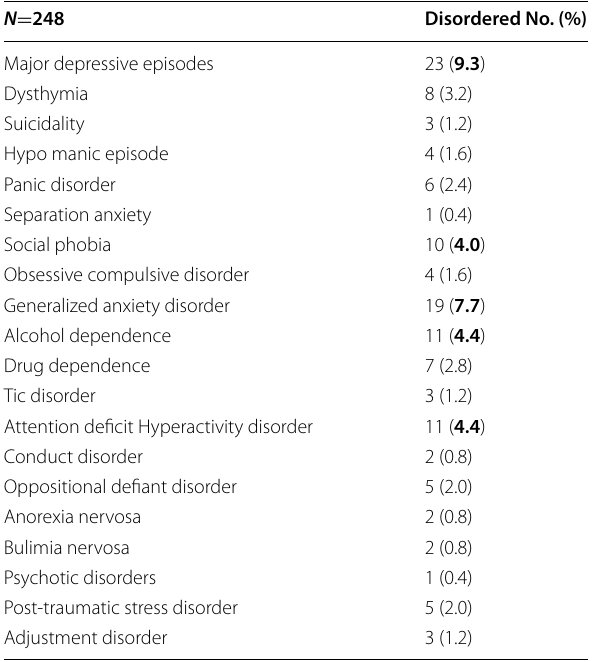
Table 2 Distribution of the results of Mini-kid psychiatric disorders among disordered individuals in the study